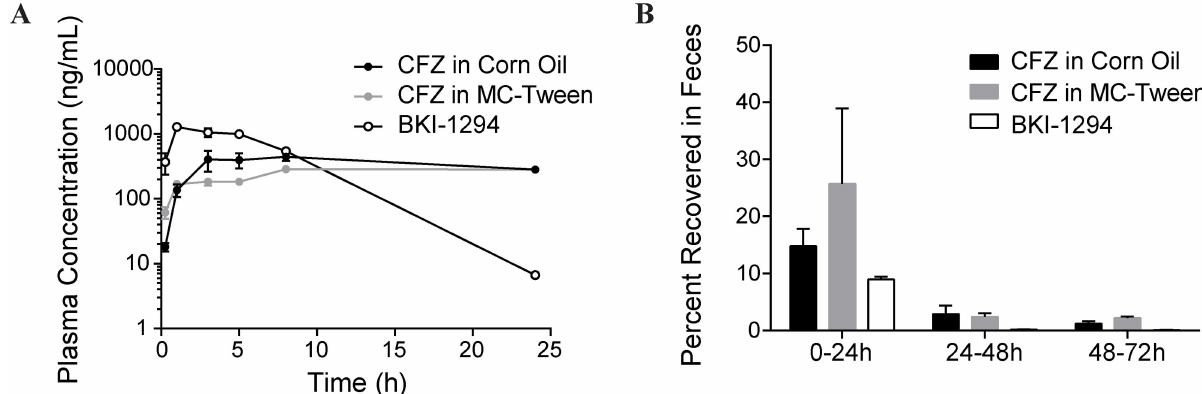
Fig 5. Pharmacokinetic properties of CFZ. (A) Plasma concentration of CFZ or BKI-1294 in mice dosedwith 20 mg/kg compound.CFZ was formulated in either corn oil (black) or MC-Tween (gray); BKI-1294 was formulated in 7% Tween 80, 3% ethanol, and 90% water (white). Data shownare mean ± SEM (n = 3). (B) UnchangedCFZ or BKI-1294 recoveredin the feces of mice dosedin (A). Recovery was measured each day for three days. Data shown are mean ± SEM (n =